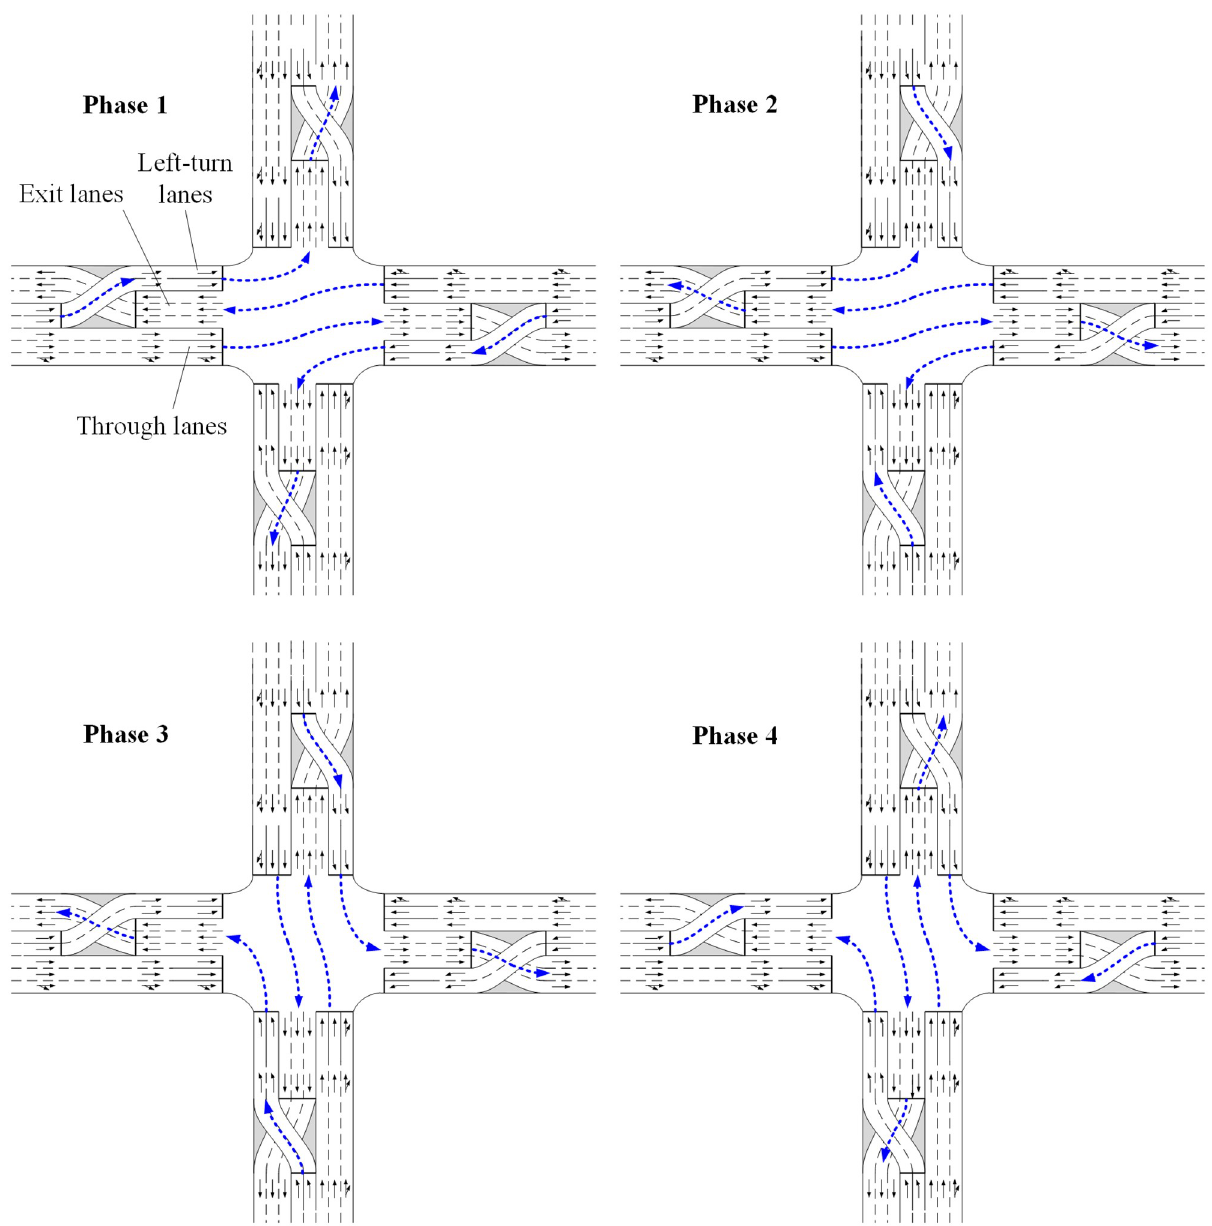
Fig 1. Phase plan and movements at